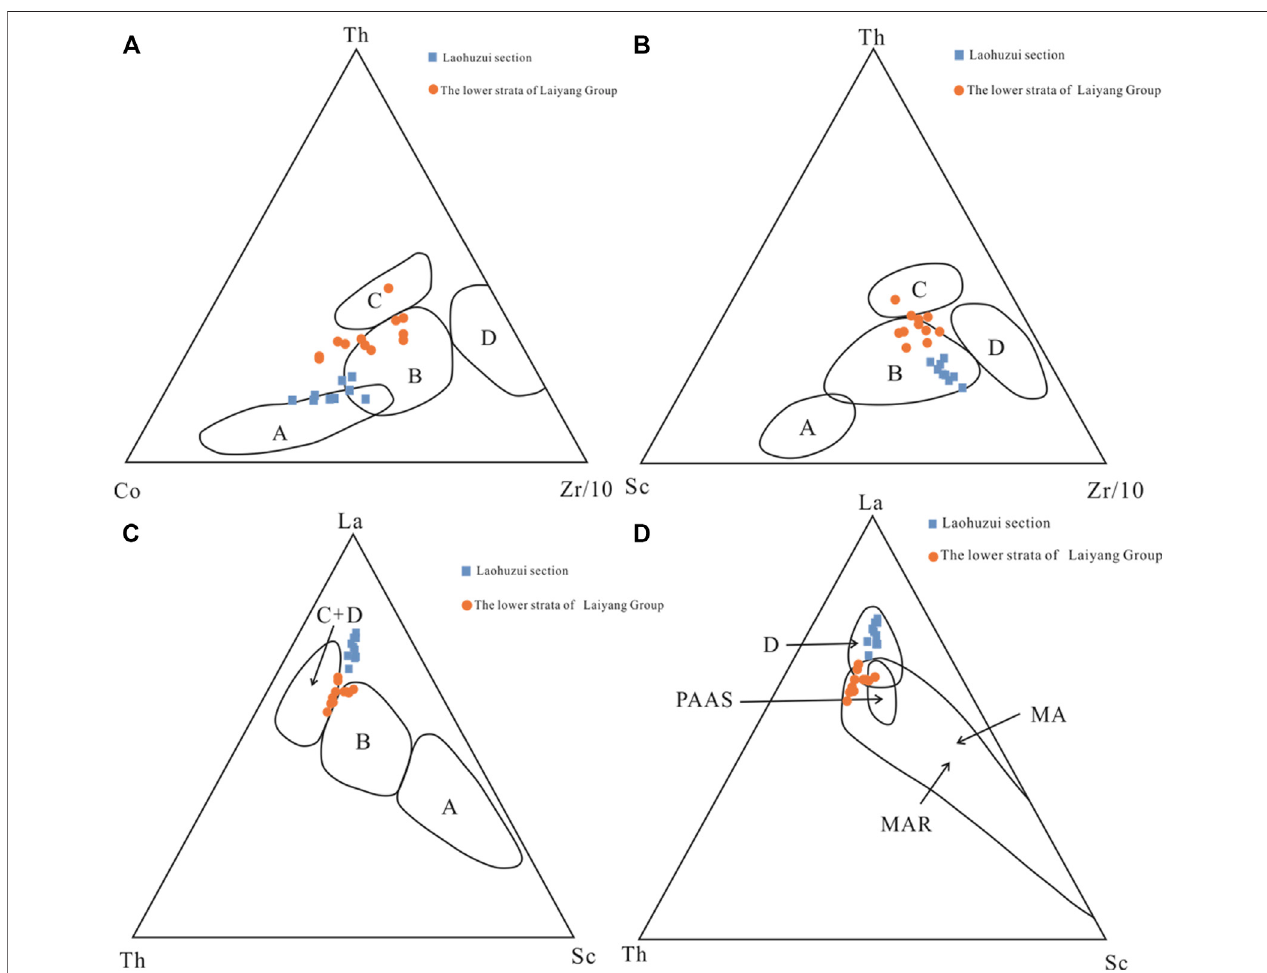
FIGURE 10 | Trace element plots of siltstones from the Laohuzui section for tectonic discrimination. (A) Th – Co – Zr/10 diagram, after Bhatia and Crook (1986). (B) Th – Sc – Zr/10 diagram, after Bhatia and Crook (1986) (C) La – Th – Sc, after Bhatia and Crook (1986). (D) La – Th – Scdiagram, after Girty et al.(1993) (PAAS: post-Archean Australian shale; MA: model andesite; MAR: magmatic arc related; (A) oceanic island arc; (B) continental island arc; (C) active continental margin; and (D) passive continental margin).